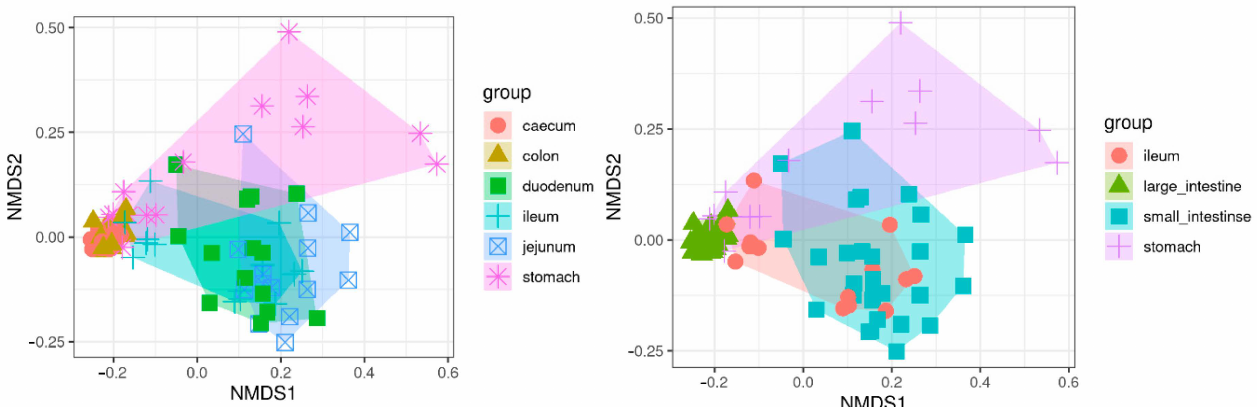
Figure 5. Beta diversity. Multidimensional scaling plot of Bray–Curtis distances between rabbit samples based on their microbiota. Left: clustering by the six regions of the gastrointestinal tract analyzed in this study. Right: regrouping based on observed microbiota similarities: large intestine (caecum and colon), small intestine (duodenum and jejunum), ileum and stomach. The first two dimensions from non-metric multidimensional scaling are plotted.